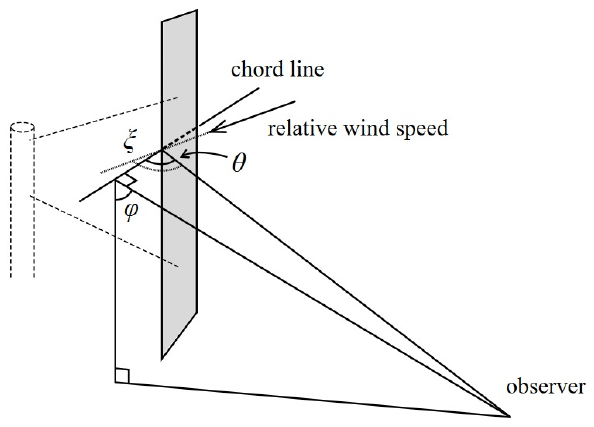
Figure 1. Definition of the angles θ , φ and ξ.